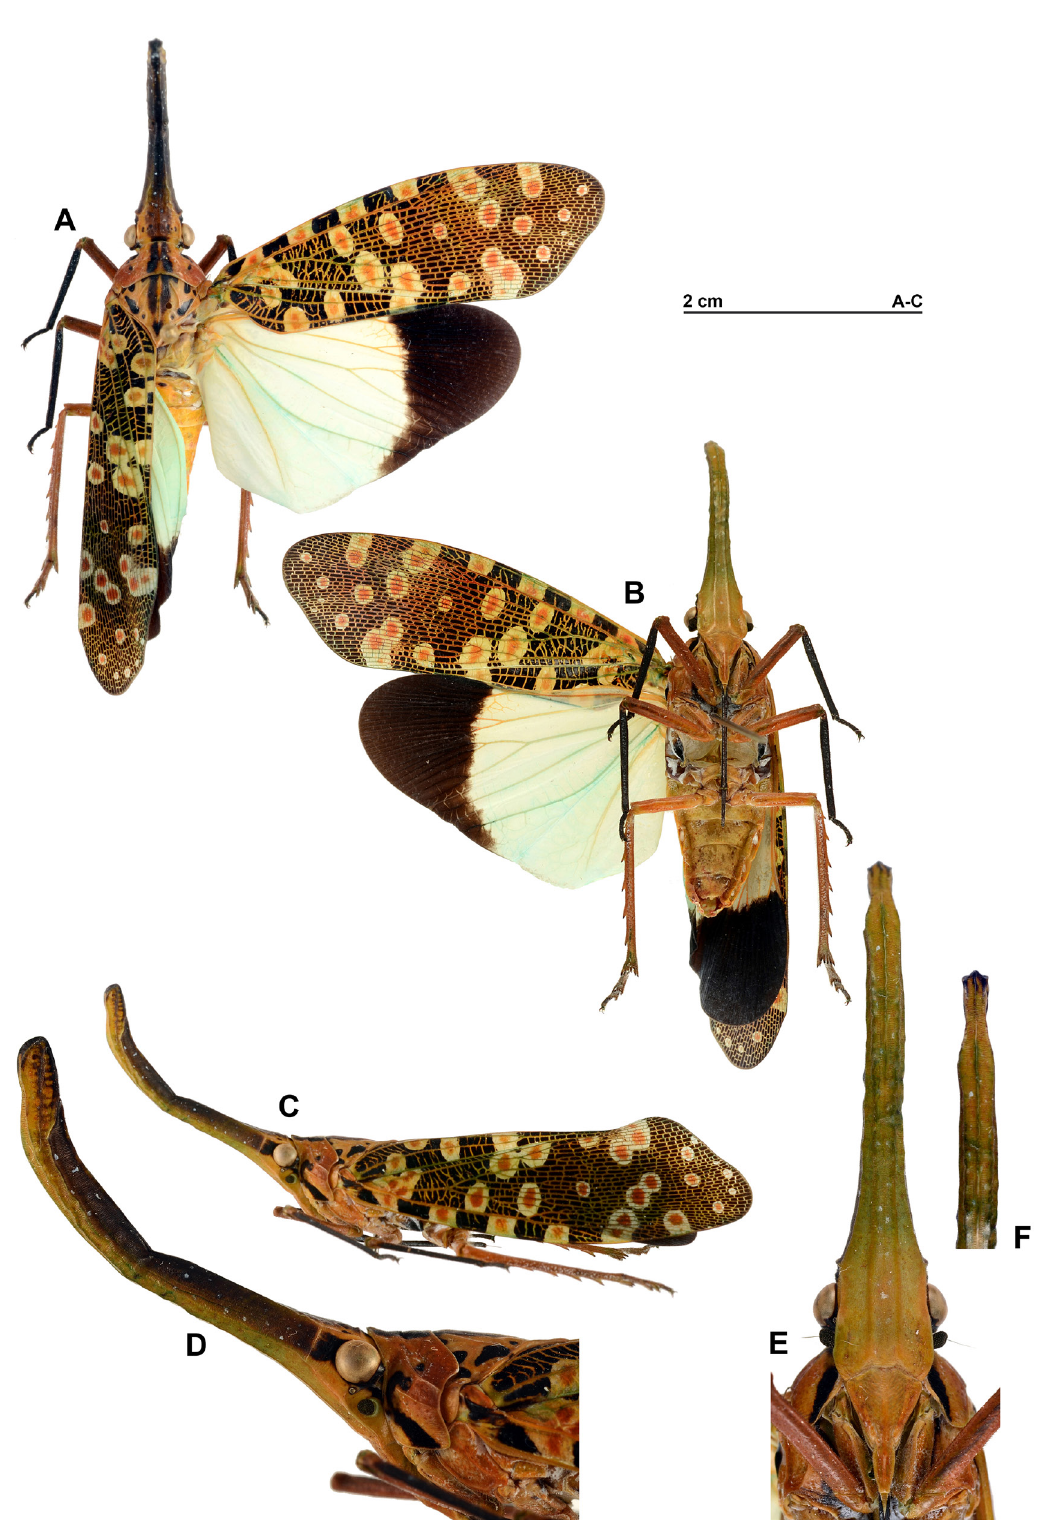
Fig. 5. Pyrops condorinus (Lallemand, 1960), ♂, Vietnam, Phu Quoc N.P., 14 Apr. 2013 (VNMN). A . Habitus, dorsal view. B . Habitus, ventral view. C . Habitus, lateral view. D . Head and thorax, lateral view. E . Head, perpendicular view of frons. F. Apex of cephalic process, anteroventral view. D–F = not to